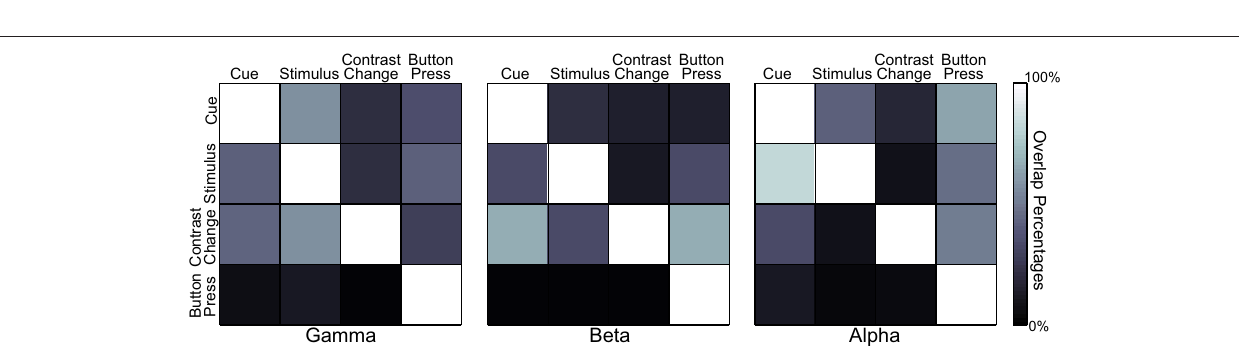
FIGure 8 | Overlap percentages of accumulated activations across four task states in each spectral band. A color-coded element at row i and column j represents the percentage of the activations at state i that are present in activations at state j for a particular